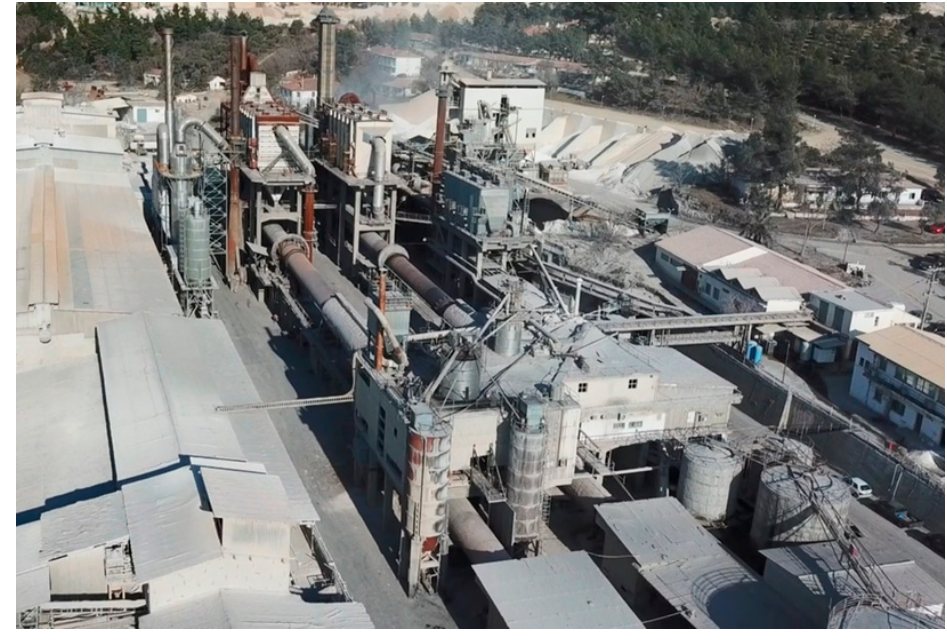
Figure 1. GMs calcination plant.